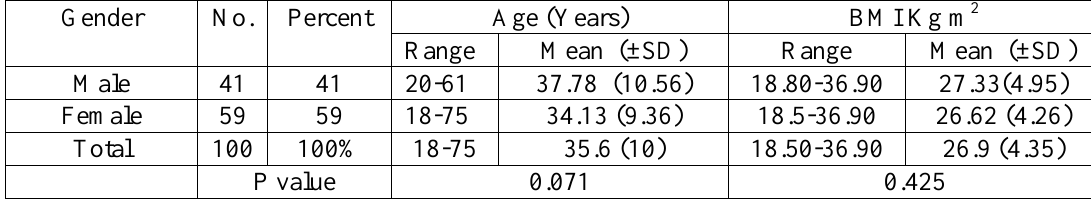
Table 1: Distribution of patients by gender, age and body mass index (BMI) grades Gender